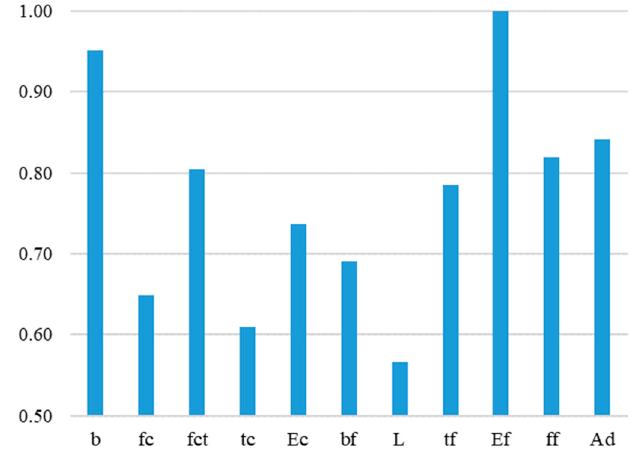
Figure 10. Relative importance of the input parameters.